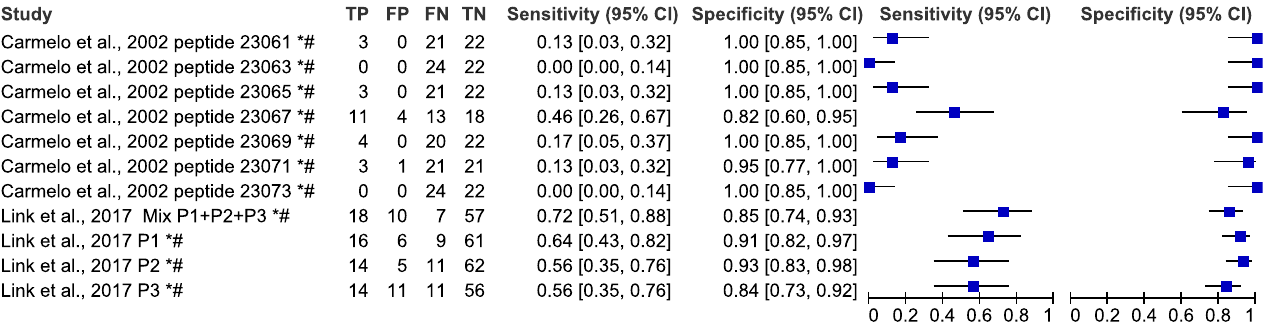
Figure 4. Forest plot representing percentage of sensitivity and speci fi city of different peptide-based tests for cutaneous leishmaniasis (CL only) diagnosis. * studies where the counts of true positive (TP), false positive (FP), false negative (FN), and true negative (TN) results were estimated from the sensitivity and speci fi city values. # studies where sensitivity and speci fi city were recalculated considering all non-cases in a single control group.